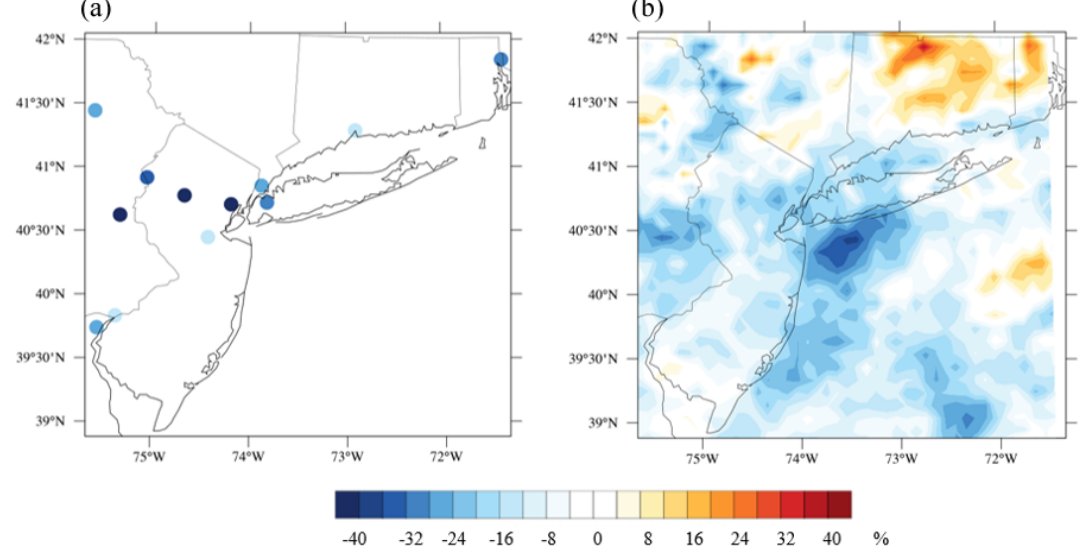
Figure 7. NO x differences observed by (a) AQS and (b) OMI from summer 2011 to summer 2018 over the LIS model